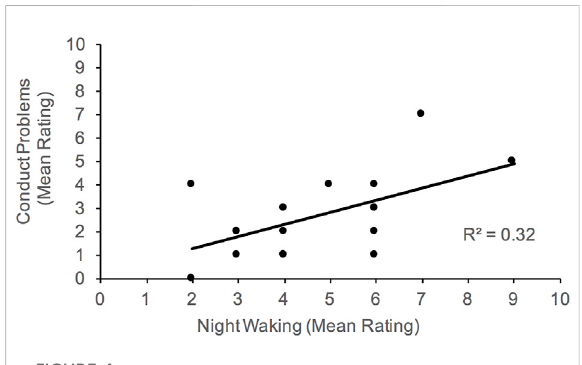
FIGURE 4 Association between conduct problems and night waking. Higher scores on night waking re fl ect more problems with sleep maintenance.